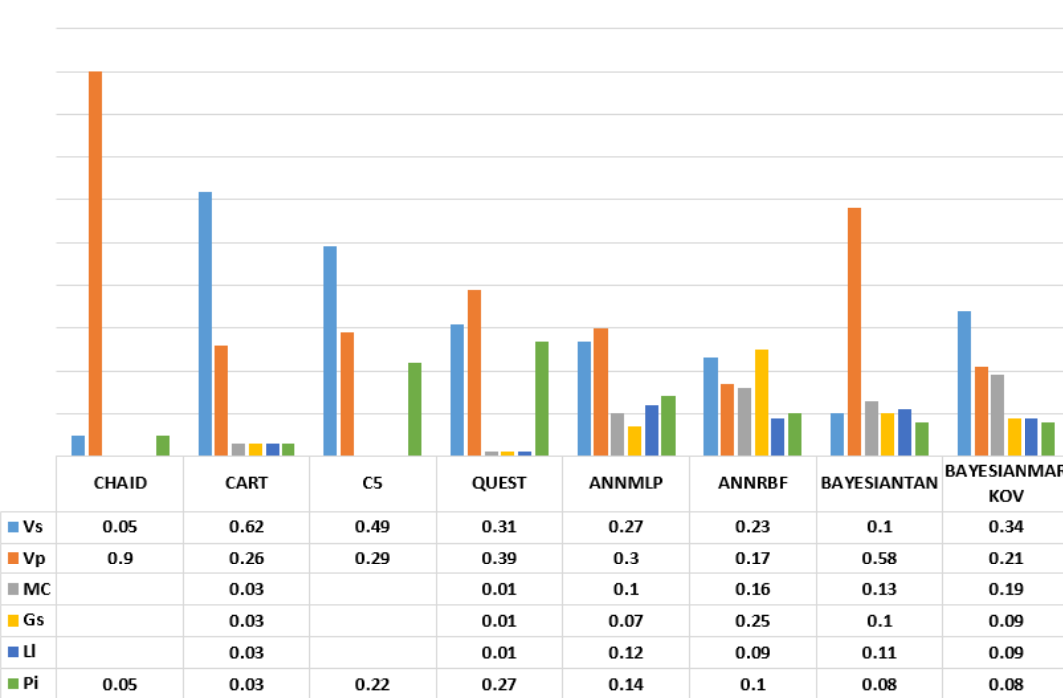
Figure 14. Importance of variables derived from various models employed.